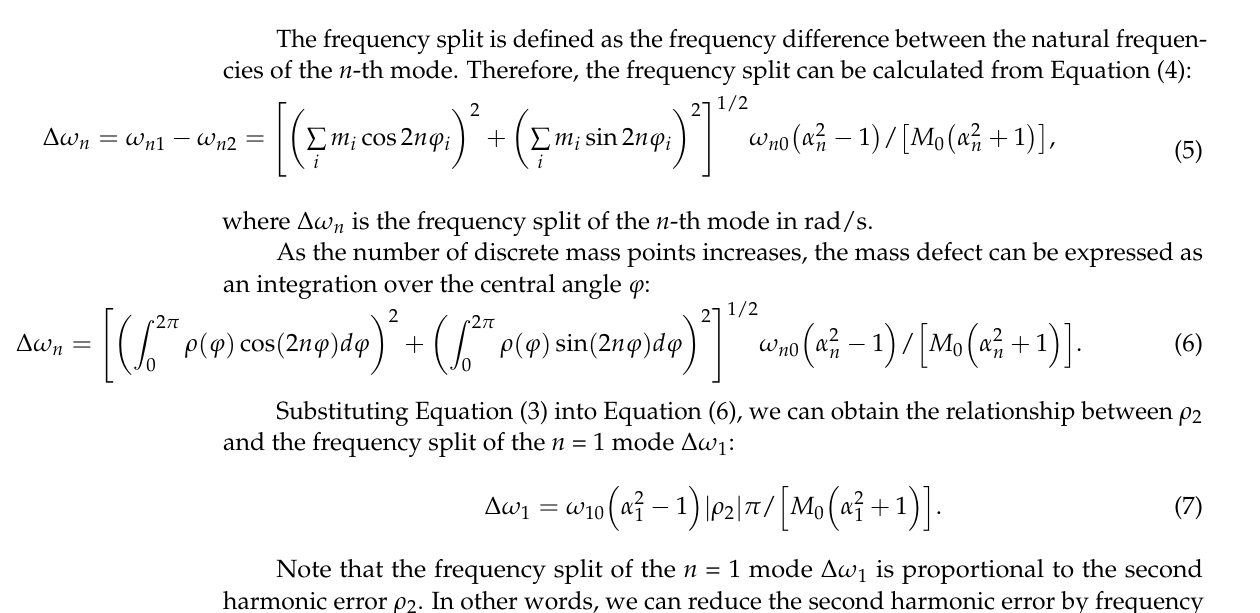
Figure 1. The ring with attached mass points.